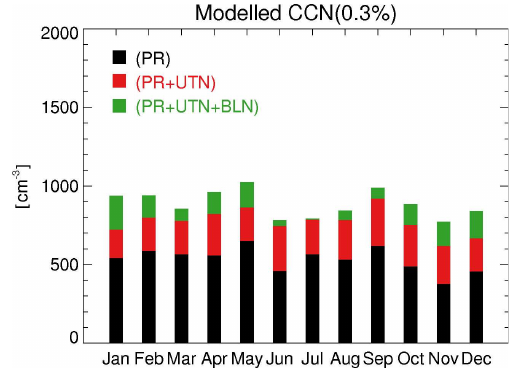
Fig. 10. Modelled size and composition resolved CCN concentra- tions at 0.3% supersaturation when accounting for the composi- tion of particles by using a hygroscopicity parameter, κ (Petters and Kreidenweis, 2007), for the kinetic sulphuric acid nucleation (Eq. 1) and the standard secondary organics